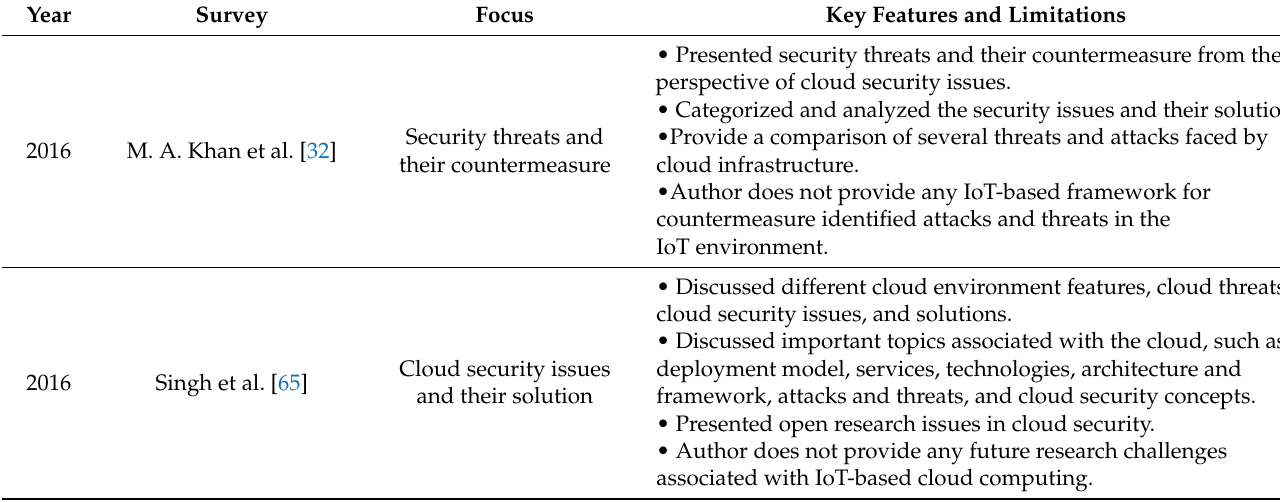
Table 2. Summary of related